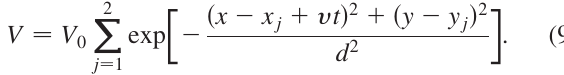
FIG. 3. (a)–(h) Snapshots of the density j c j 2 =n (cid:7) ¼ arg c profiles in the rest frame. A Gaussian potential with Þ ¼ (cid:2) 5 is moved as in Eq. (8) with v = ð gn V 0 0 ¼ 17 . The beam waist is d=(cid:2) ¼ 3 : 54 in (a)–(d) and d=(cid:2) ¼ T=t 0 2 : 67 in (e)–(h). The arrows in (c) and (g) indicate the traveling direction of the vortex dipoles. The phase profiles (d) and (h) magnify the regions in the dashed squares in (c) and (g). The field of view of (a)–(c) and (e)–(g) is 78 (cid:2) (cid:5) 33 (cid:2) . (See also Supplemental Material [31].) (i) Velocity of the launched vortex dipole versus beam waist d for v (squares), and 0.41 (triangles). The other parameters are the same as those in